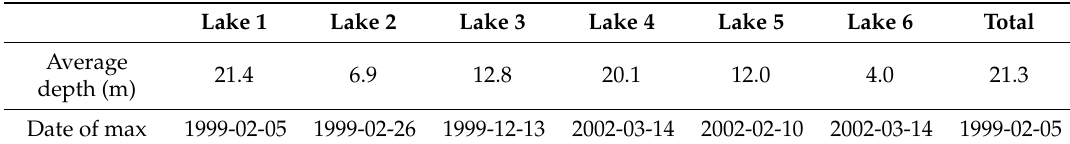
Table 6. Maximum average depth and date of maximum for each